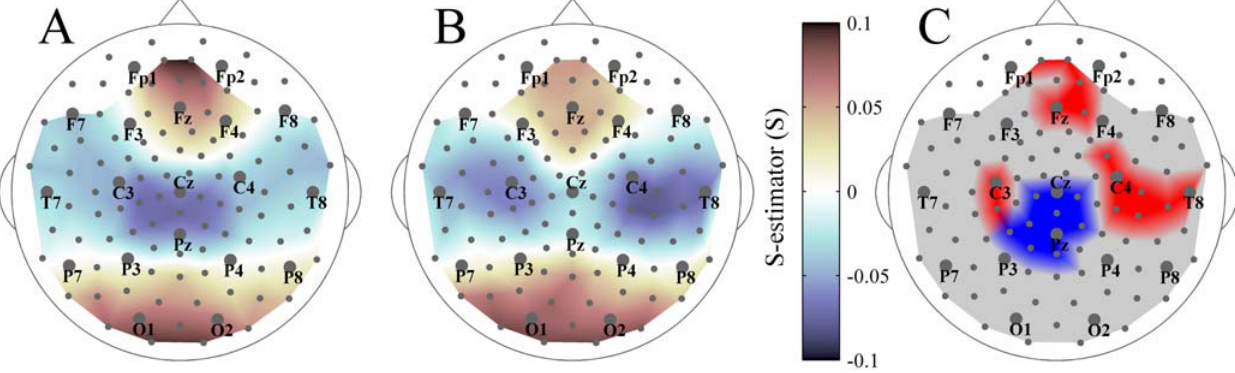
Figure 2. Whole-head S-estimator maps for SZ patients and normal controls. Group-averaged maps for the broad-band resting EEG (1–70 Hz) are shown for patients (A) and controls (B). C: Difference map, Patients vs. Controls. Here and hereafter the clusters of sensors with S-estimator significantly higher or lower in patients than in controls are in red or blue, respectively. There are no significant differences in the gray regions.